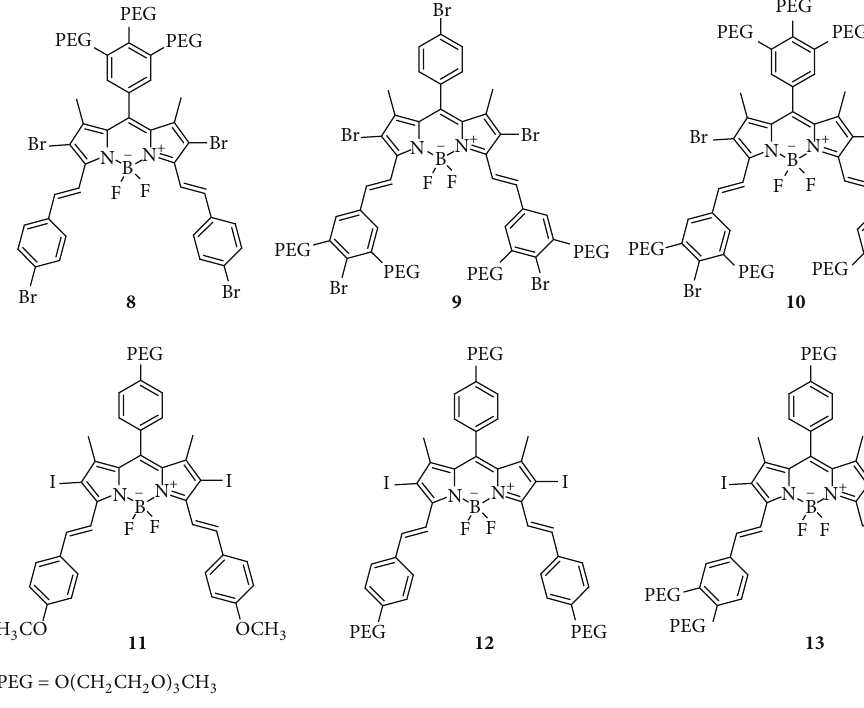
Figure 6: Structures of BODIPY 8 – 13 .